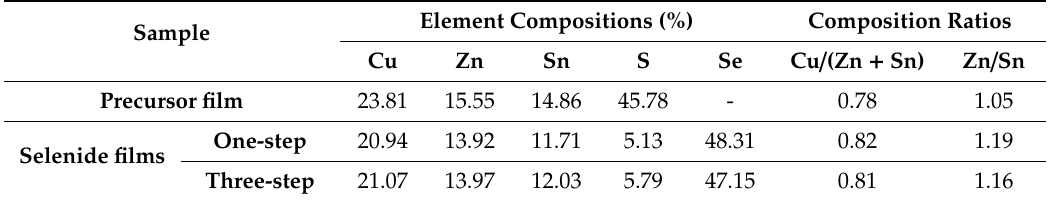
Table 1. The measured chemical compositions of the CZTS precursor film and CZTSSe films. Element Compositions (%) Composition Sample